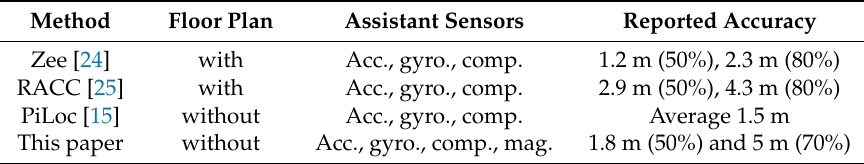
Figure 21. Wi-Fi RPs generated in the constructed map. Table 5. Results comparison with method proposed by other researchers.